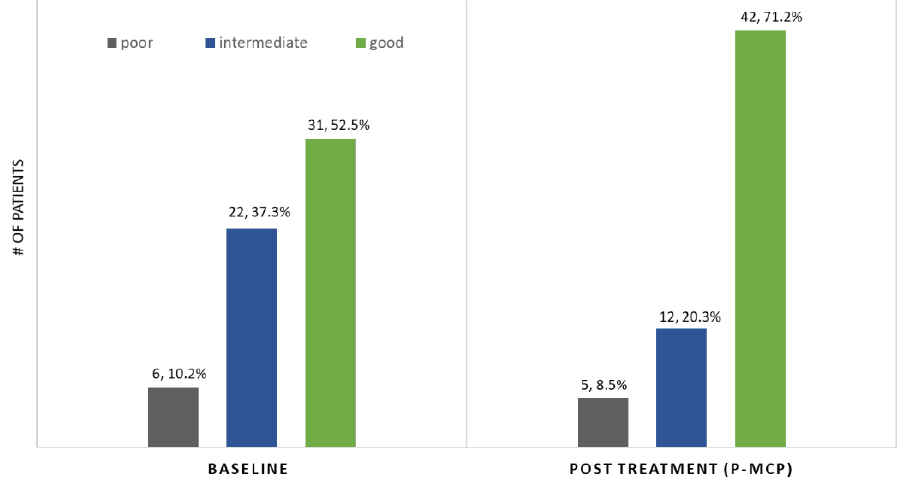
Figure 3. PSADT risk grouping: pre- versus post-P-MCP ( n , %).